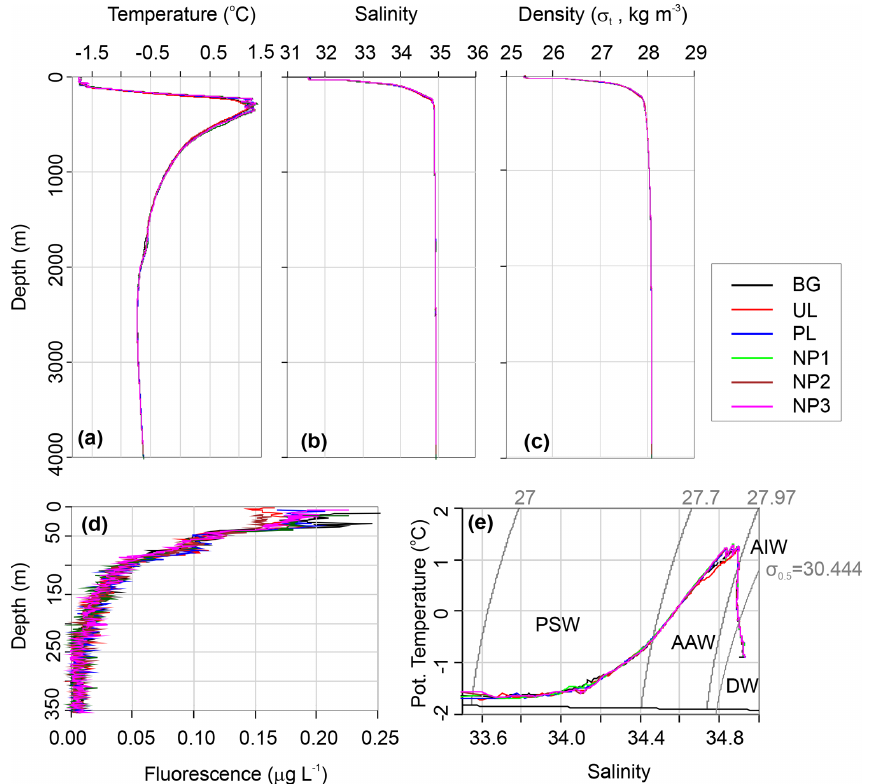
Figure 2. Depth profiles of (a) in situ temperature, (b) salinity on the practical salinity scale, (c) potential density, (d) Chl a fluorescence, and (e) potential temperature vs. salinity profile along with the characterized water masses, Polar Surface Water (PSW), Arctic Atlantic Water and Arctic Intermediate Water (AAW/AIW), Arctic Deep Water (DW) in the background (BG), upper layer (UL), plume (PL) and non-plume (NP1–NP3)